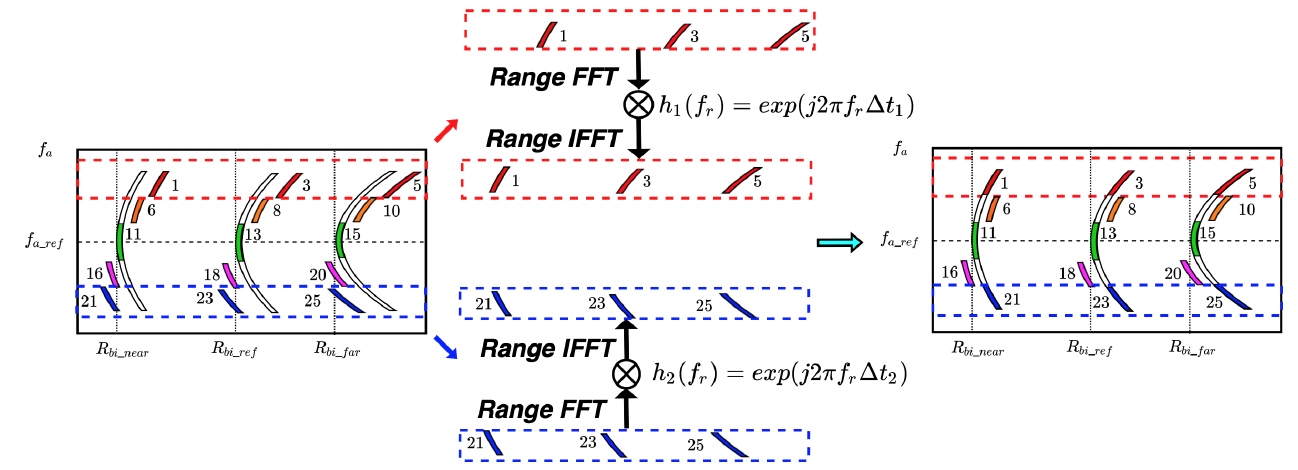
Figure 6. The specific correction steps for the azimuth variance.